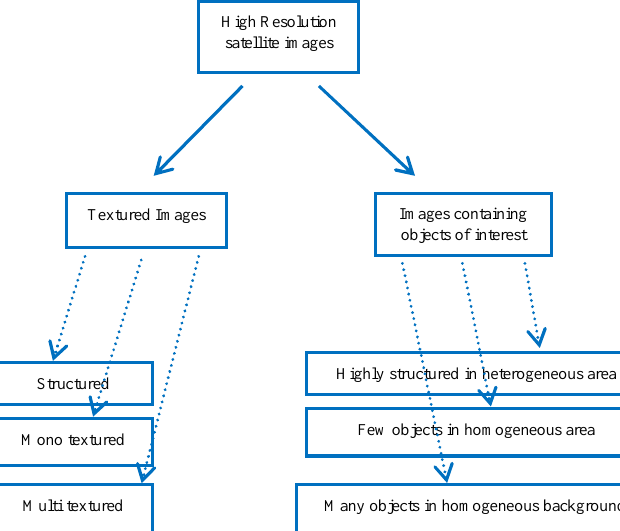
Figure 10. Adapting labelling to high resolution satellite images